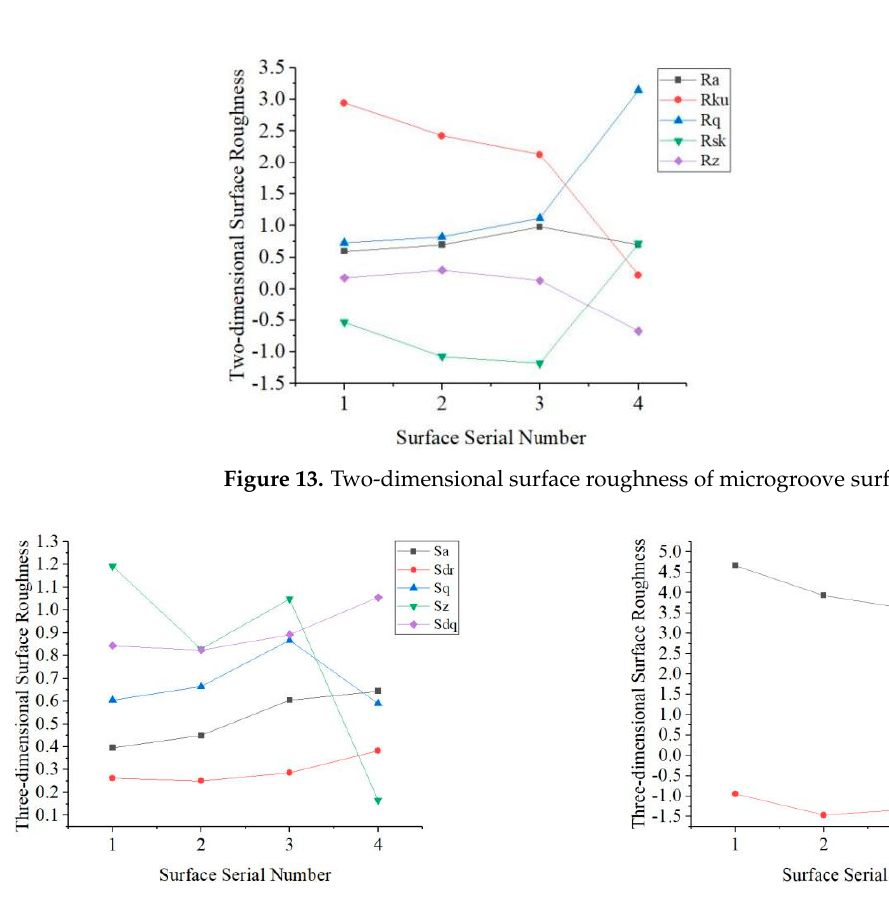
Figure 14. Three ‐ dimensional surface roughness of microgroove surfaces.